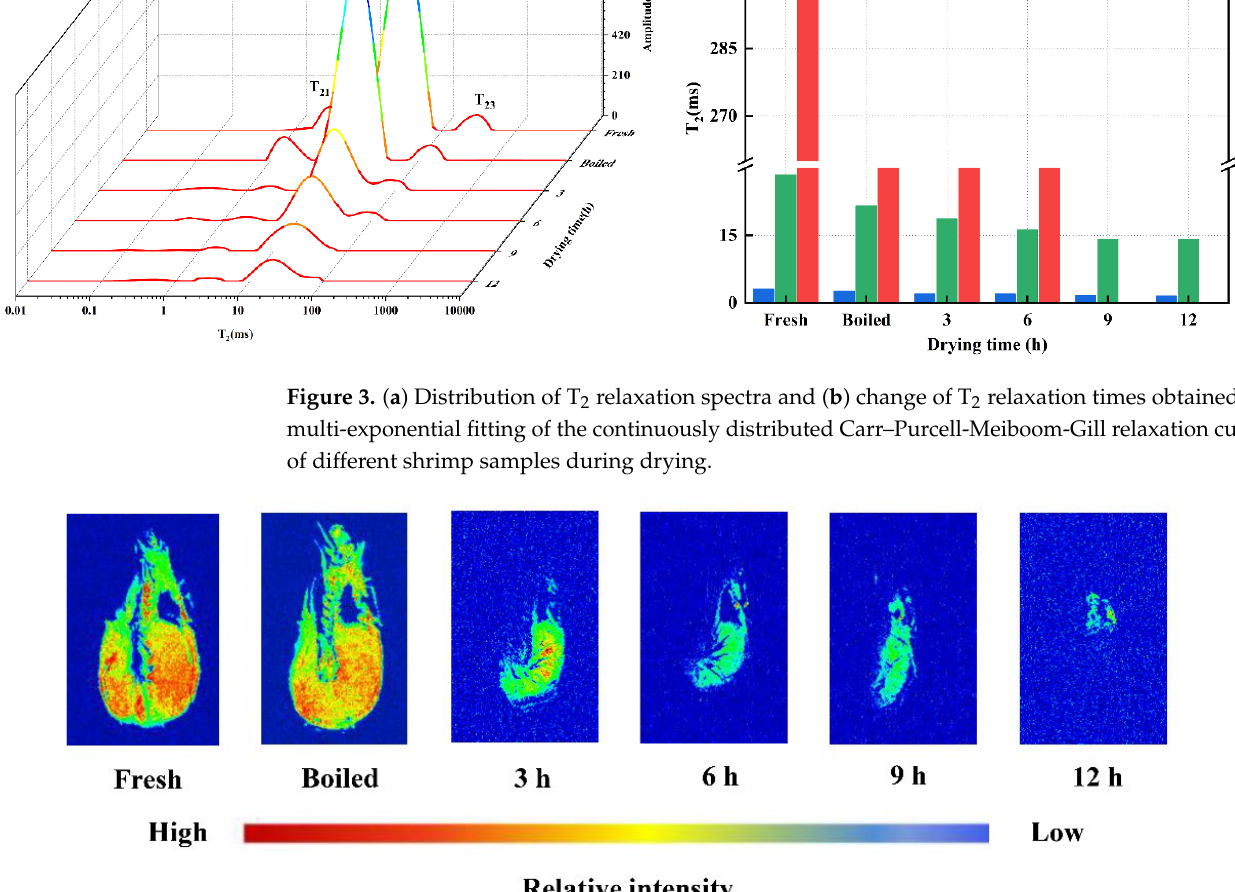
Figure 4. T 2 weighted MRI images of shrimp dried by hot air drying at different levels .